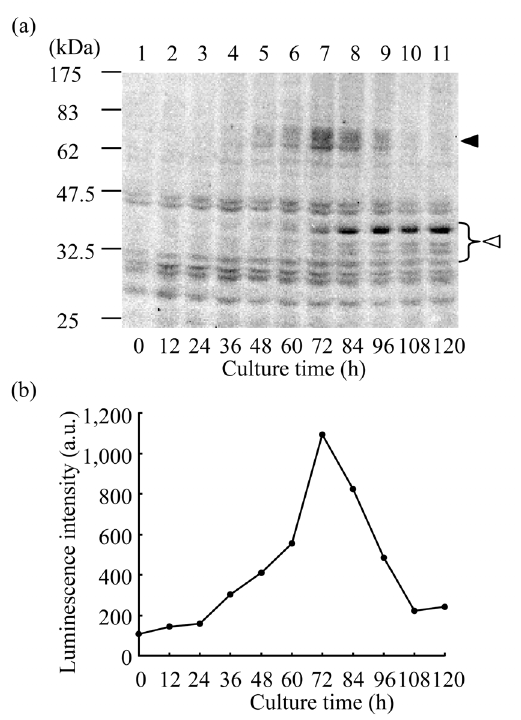
Fig. 4 Expression level of His-tagged prestin in Sf9 cells. (a) Result of Western blot analysis. Lanes 1–11: cells harvested at 0–120 h after infection. The solid arrowhead and the open arrowhead indicate prestin and fragments of degraded prestin, respectively. (b) Time course of the expression level of prestin. The expression levels in the cells up to 120 h after infection were evaluated from the luminescence intensity of Western blot bands at around 70